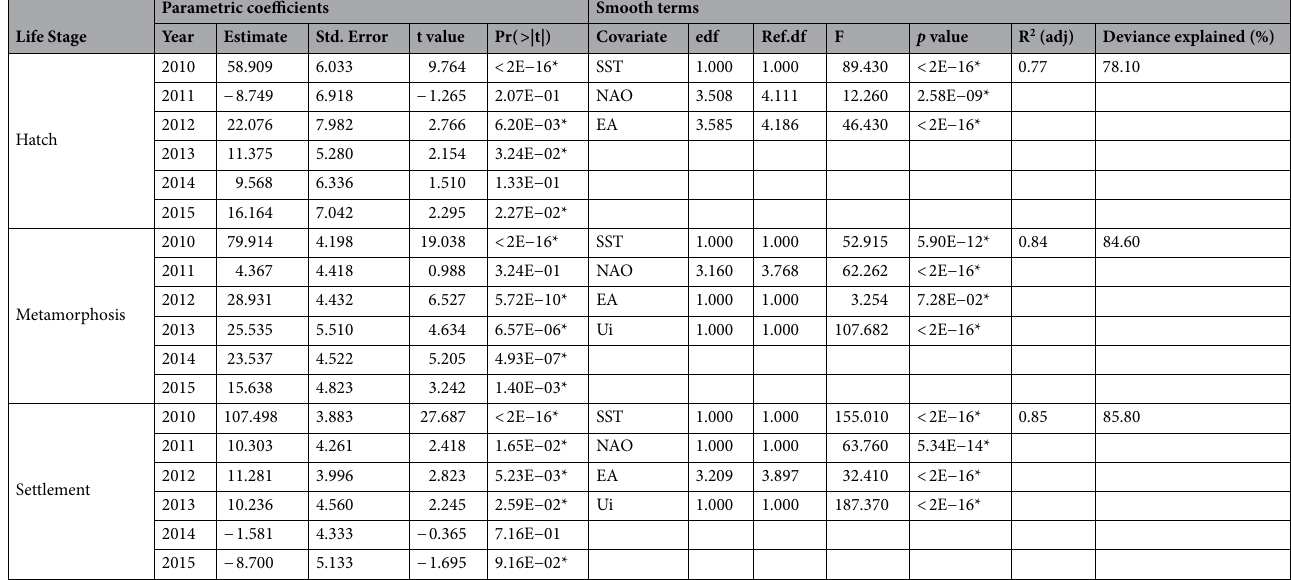
Table 2. Generalized additive model (GAM) outputs for parametric coefficients and smooth terms testing the interaction between environmental variables and Platichthys flesus hatch, metamorphosis, and settlement days between 2010 and 2015. Significant terms are highlighted with